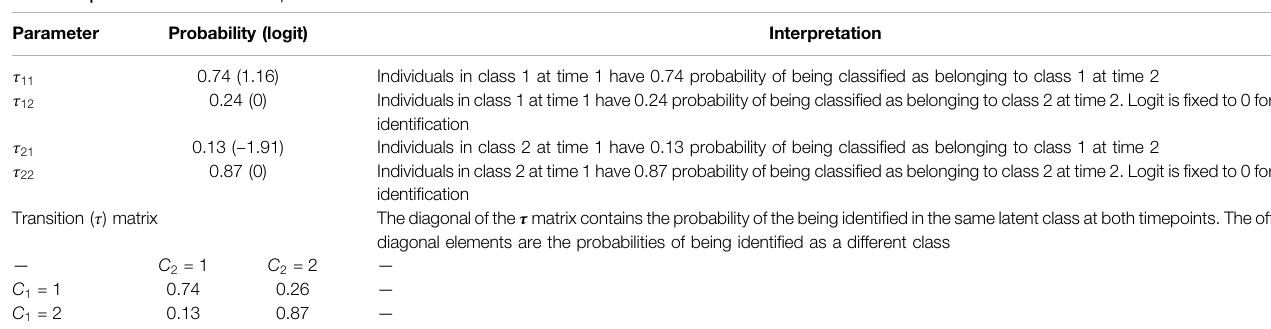
TABLE 4 | Transition structure interpretation for an 2-class multilevel LTA